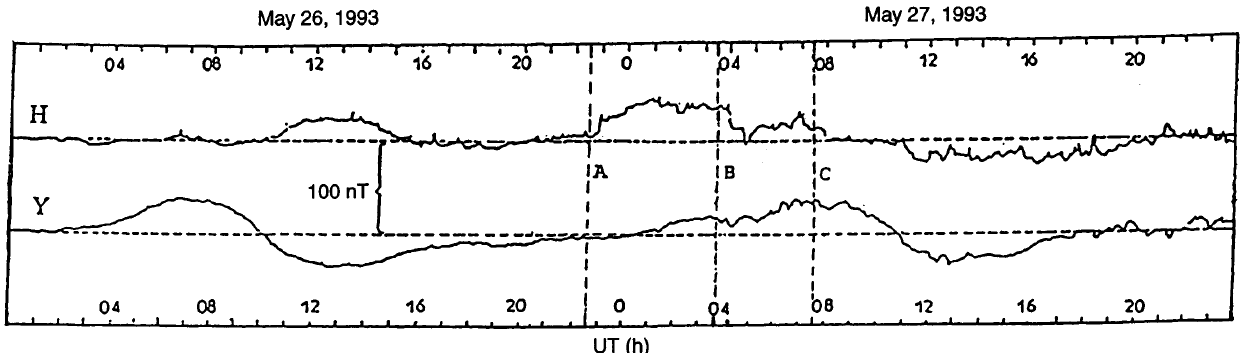
Fig. 7. H - and Y -component of the earth magnetic field recorded at EBR (dip: 46.06 (cid:176) ) in mid-latitude on 26 and 27